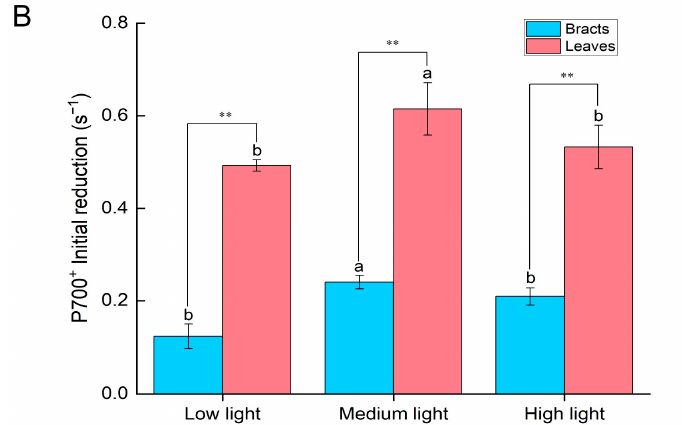
Figure 2. Effect of different light intensities on the initial reduction rate (0–0.2 s) of P700 + after turning off the far-red light (FR) in leaves and bracts, black rectangle reflects the initial reduction rate (0–0.2 s) of P700 + after turning off the far-red light as follows. ( A ) Dark reduction kinetics of P700 + with far-red light off ( λ > 705 nm, 5.2 µ mol m − 2 s − 1 , lasted for 40 s); ( B ) P700 + initial reduction rate (0–0.2 s) under different PPFDs (400 µ mol m − 2 s − 1 , low light; 1800 µ mol m − 2 s − 1 , medium light; 2800 µ mol m − 2 s − 1 , high light). Different letters indicate a significant difference ( p < 0.05) between the low, medium, and high light. ** denotes significance at the 0.01 level between the leaves and bracts based on an analysis of variance. Bars indicate SD ( n = 3).